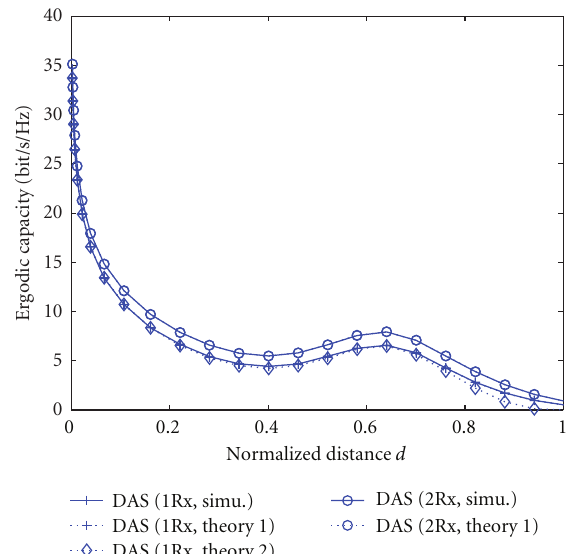
Figure 1: Ergodic capacity versus the normalized distance from the home